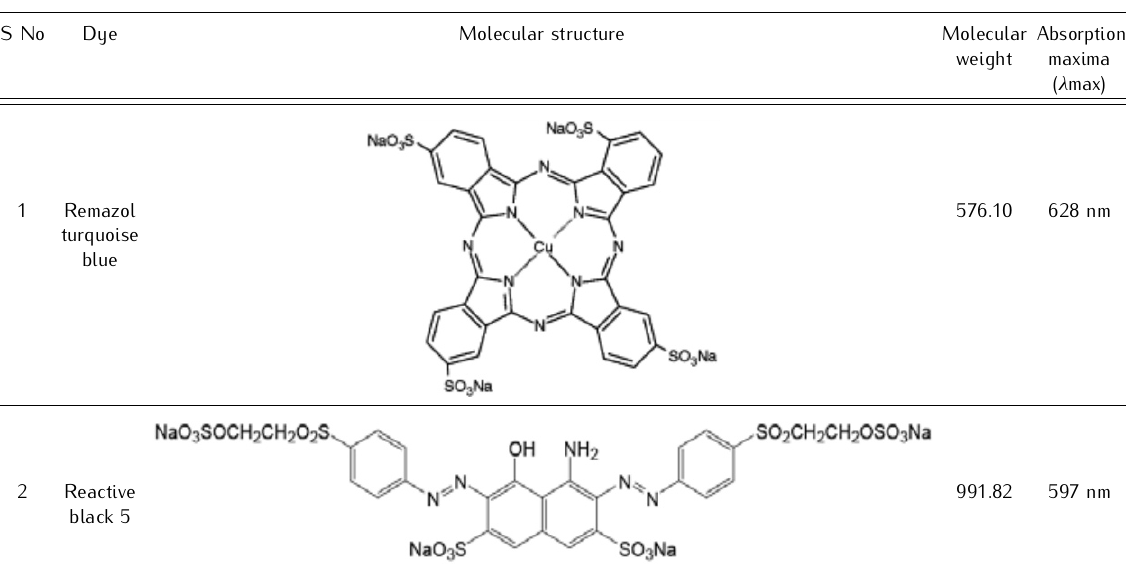
Table 1. Structure and properties of RTB and